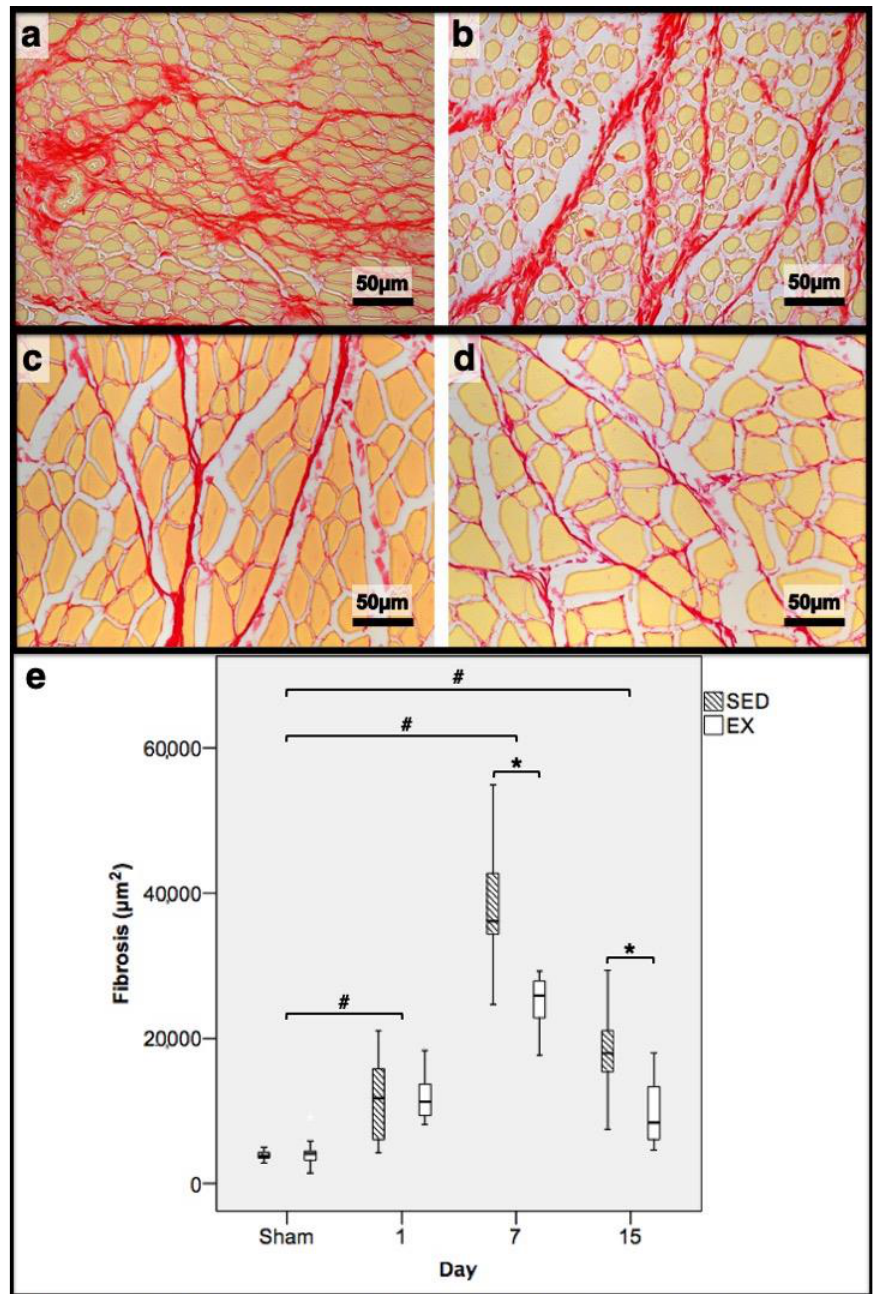
Figure 2. Representative images of the tibial anterior muscles, stained with picrosirius red, from the exercise (EX; ( a , c )) and sedentary (SED; ( b , d )) groups injected with cardiotoxin, sacrificed on the 7th ( a , b ) and 15th ( c , d ) day post-injection. In ( e ), the corresponding distribution of the fibrotic tissue area in all assessed days in both groups is depicted (Sham: overall median values of control muscles). Box = median, 25 to 75%; T-bars = minimum and maximum values. * significantly higher than EX group ( p < 0.01); # significantly higher than Sham muscles ( p < 0.01). SED—sedentary group injected with cardiotoxin; EX—exercise group injected with cardiotoxin; Sham—control muscles injected with saline